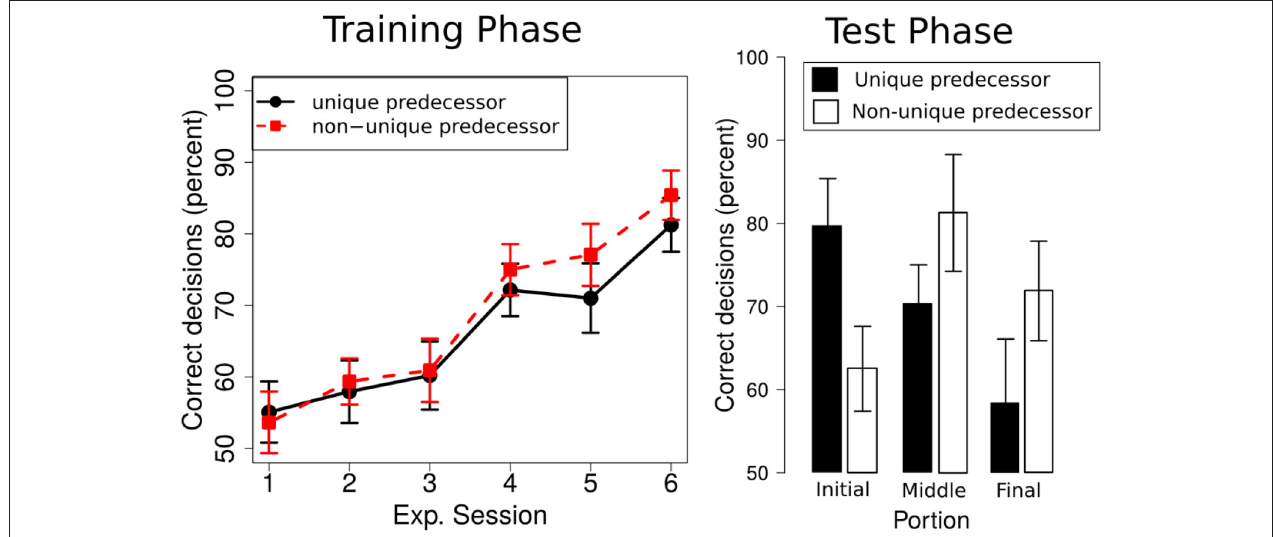
FIGURE 5 | Left: Participants’ performance in the training phase across the six experimental sessions; Right: Performance in the test phase for the unique predecessor and the non-unique predecessor trials for intersections in the initial, middle or final portion of the route.